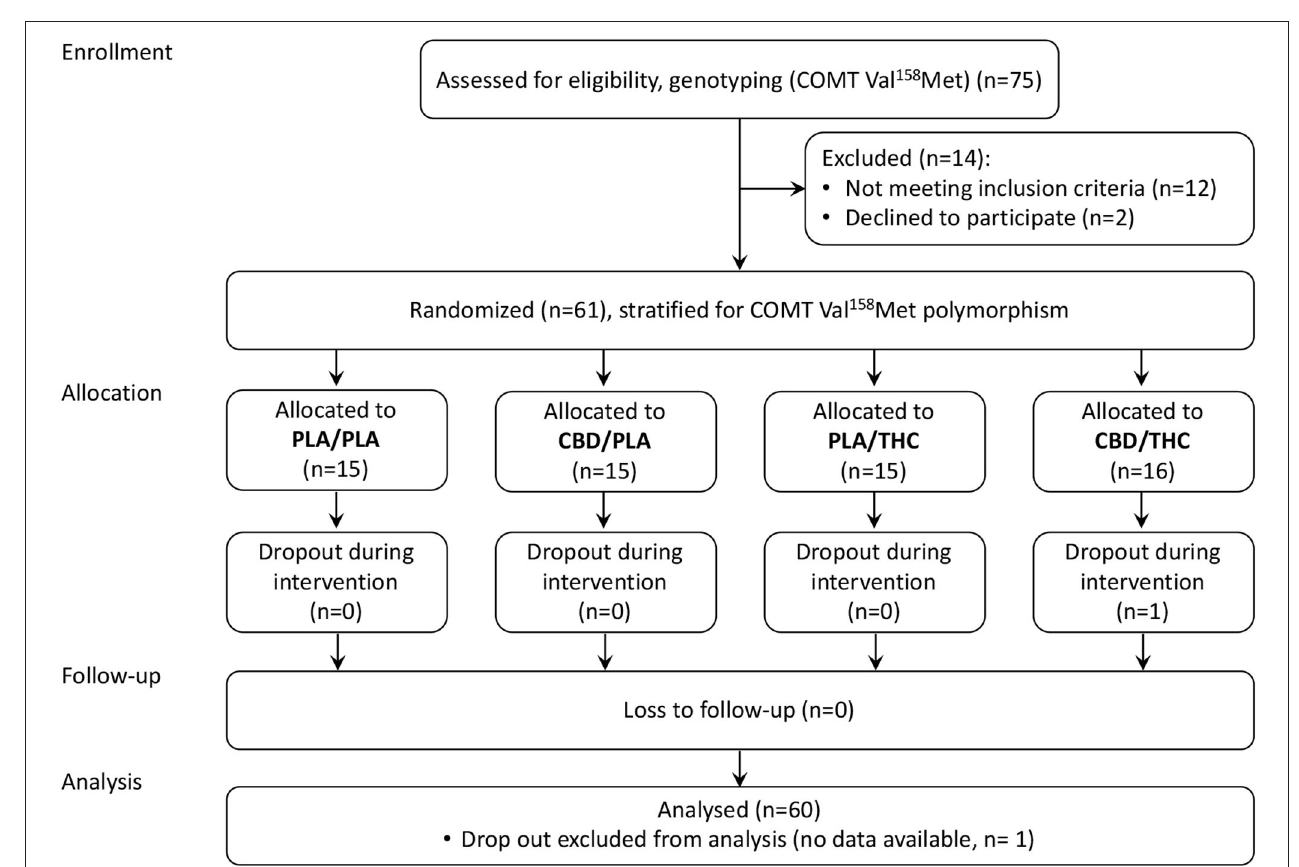
FIGURE 1 | CONSORT Flow Diagram. CBD, cannabidiol; PLA, placebo; THC,